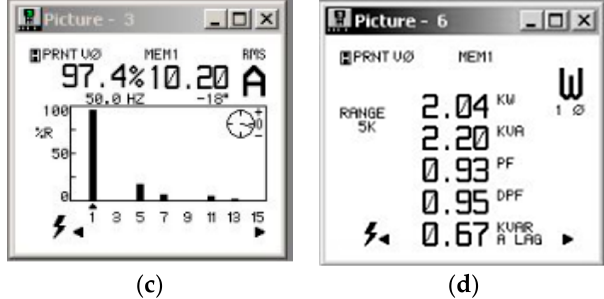
Figure 19. Experimental results for the adaptive control at nominal load on the load side, in steady state regime, provided by Fluke 41B analyzer: ( a ) waveform of the load current; ( b ) RMS value and load current THD ; ( c ) harmonic spectrum of the load current; ( d ) powers per phase and power factor.